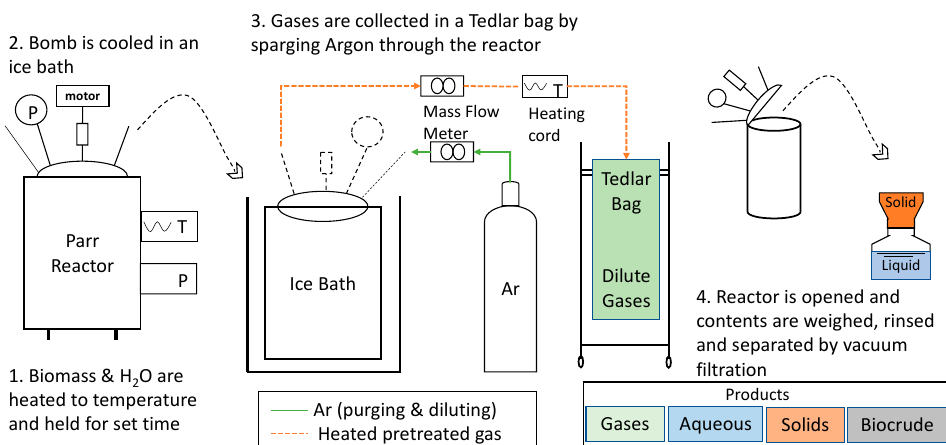
Figure 1. Flow diagram of the HTL process and product separation.